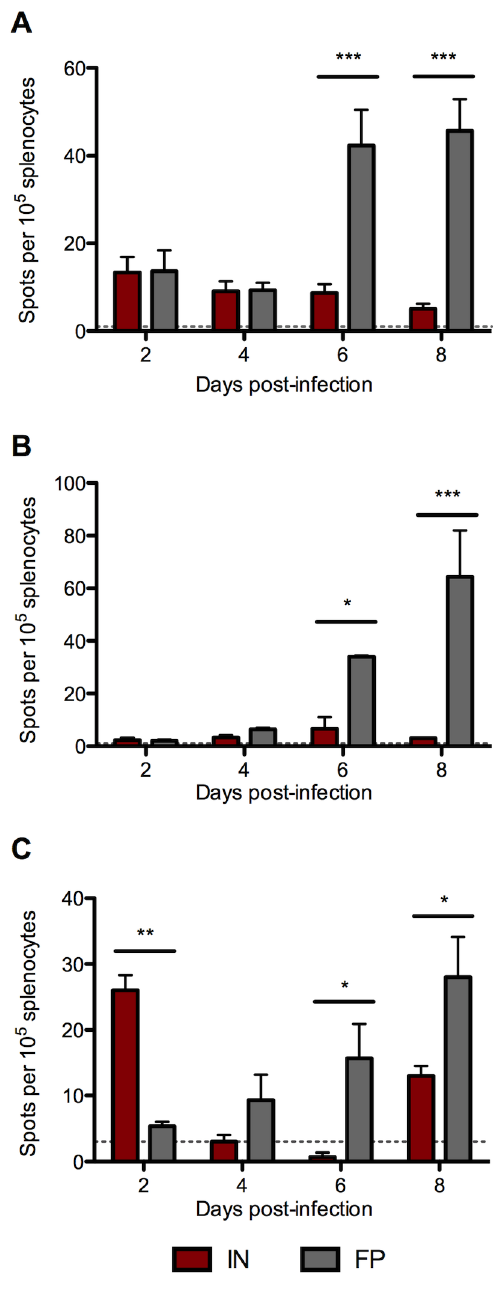
Figure 6. T cells from FP-inoculated mice mount a robust proinflammatory response in the spleen. Splenocytes were prepared from IN- and FP-inoculated mice and used in ELISPOT assays for proinflammatory cytokines including (A) IFN c , (B) TNF a , and (C) IL-2. Means based on groups of 3 mice per time point.